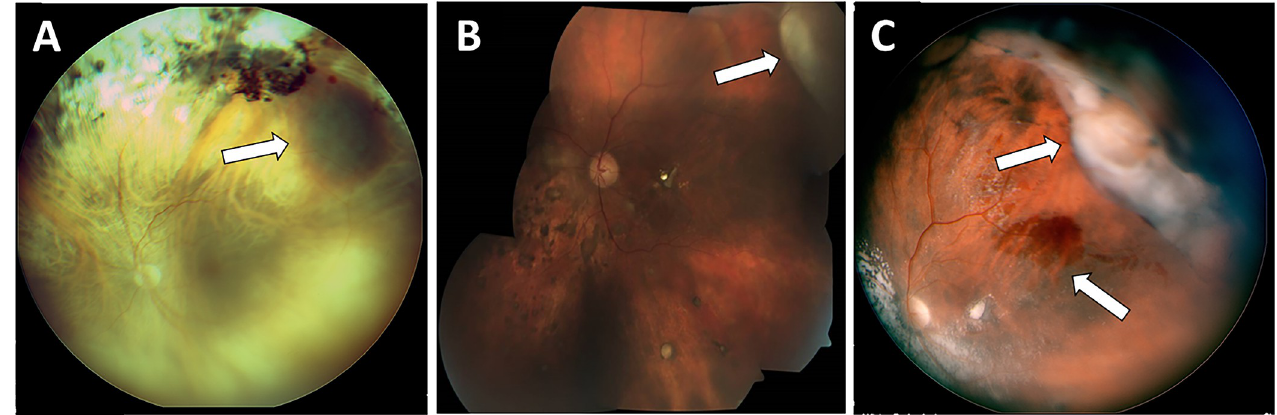
Fig 1. Clinical subtypes of PEHCR. Three different subtypes were observed in our cohort (arrows): A , Hemorrhagic; B , Exudative; C combined.